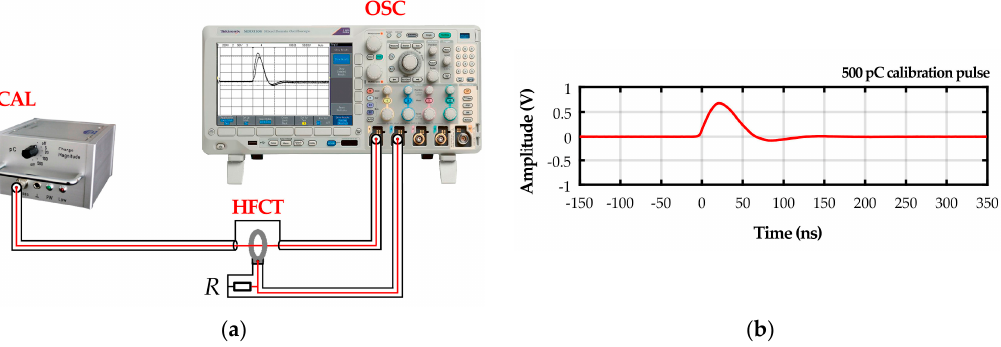
Figure 16. Examination of HFCT sensors: ( a ) Schematic diagram of the measurement setup for measuring the impulse response of the HFCT sensor using standard PD calibrator: OSC = oscilloscope Tektronix MDO3104, HFCT = high-frequency current transformer under test, CAL = partial discharge calibrator type Doble LDC-5; ( b ) time waveform of PD calibration pulse with an apparent charge of 500 pC.